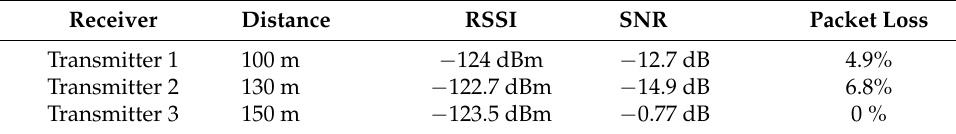
Table 1. LoRa communications performance in a real